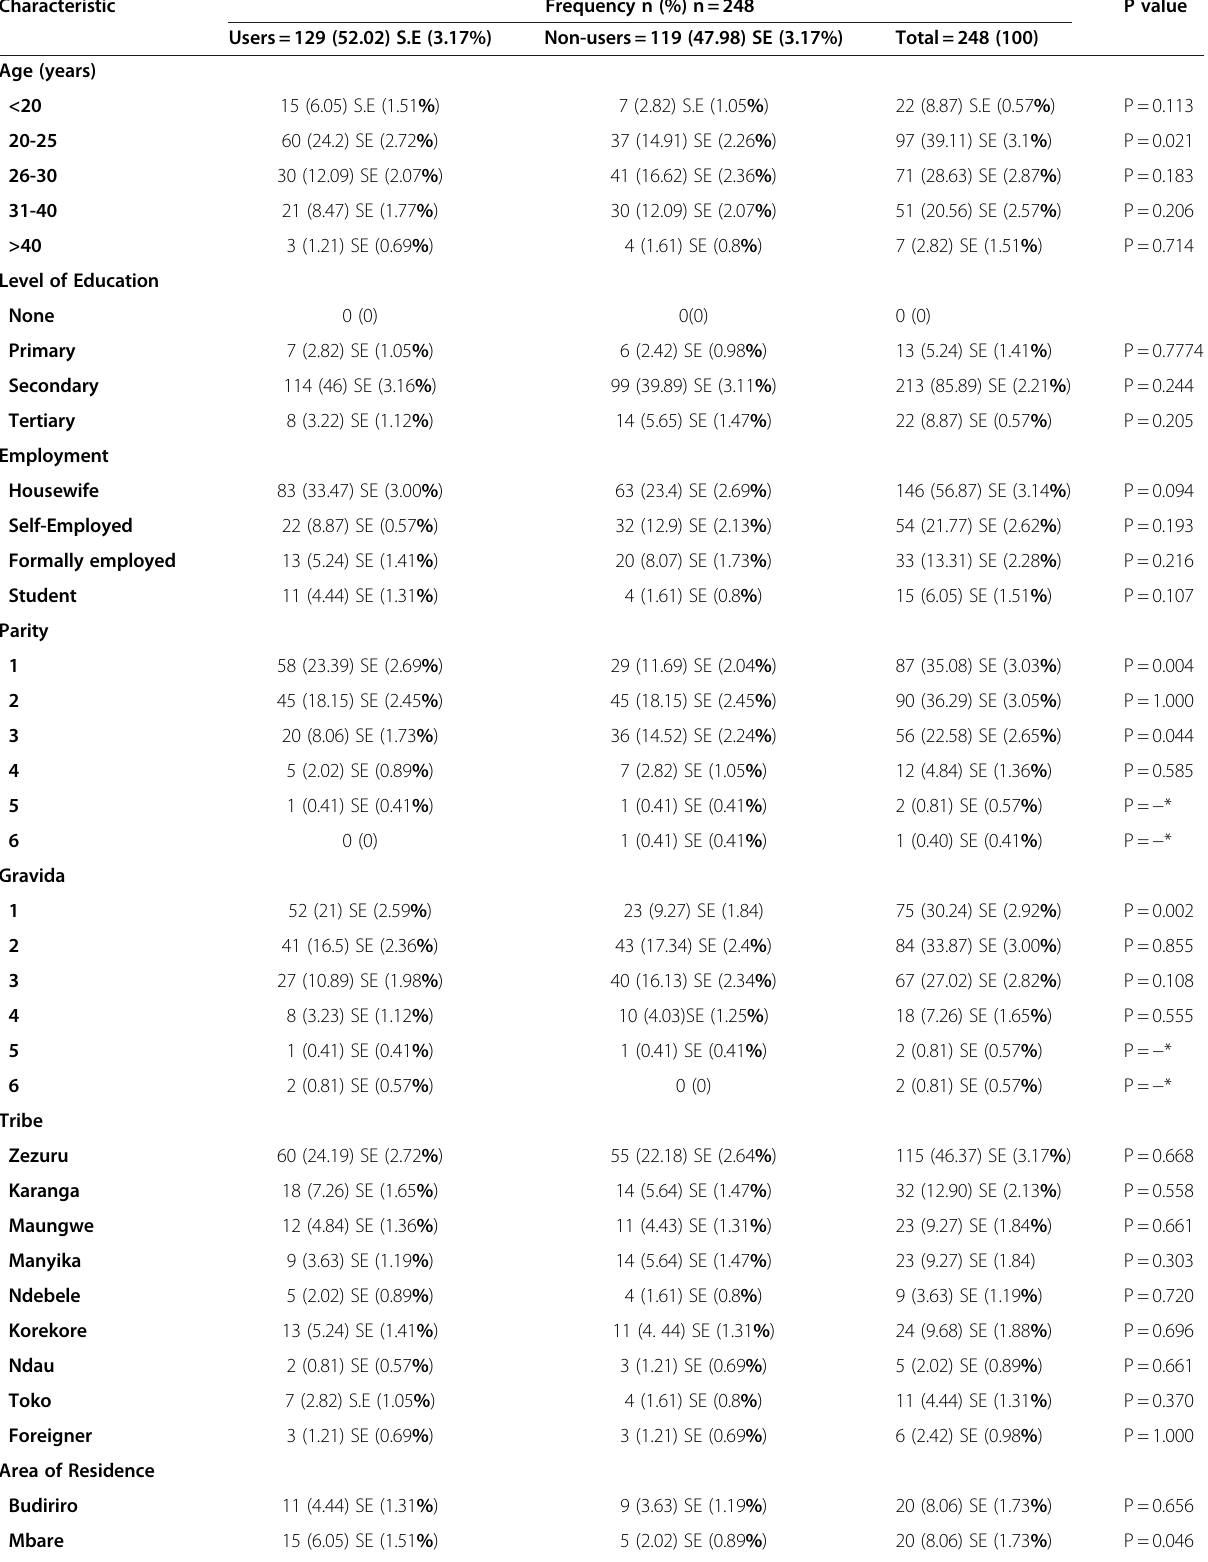
Table 1 Demographic characteristics of the study